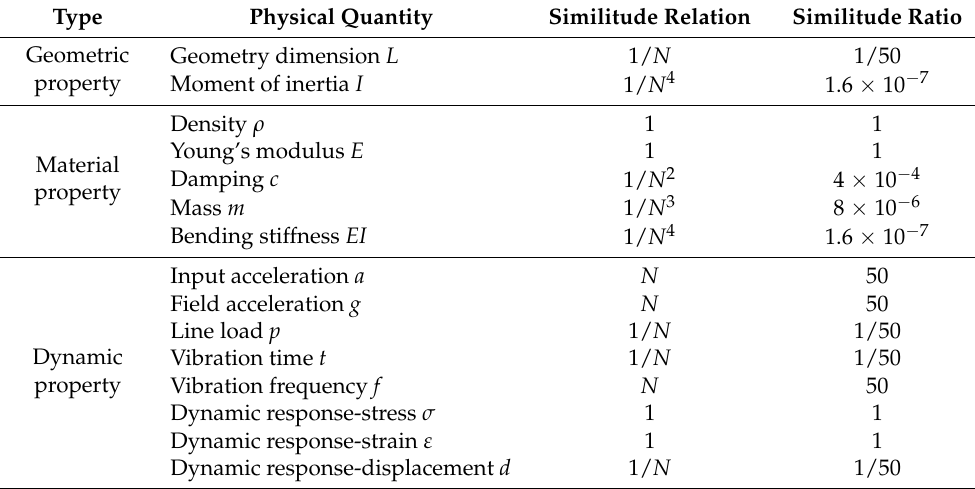
Table 1. Similitude relations used in centrifuge model test.